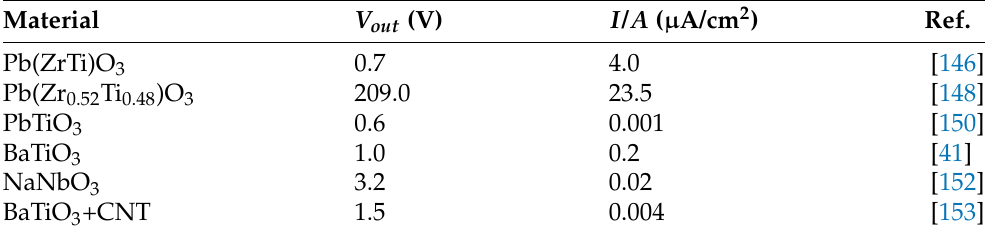
Table 7. Comparison of 1D material nanogenerators